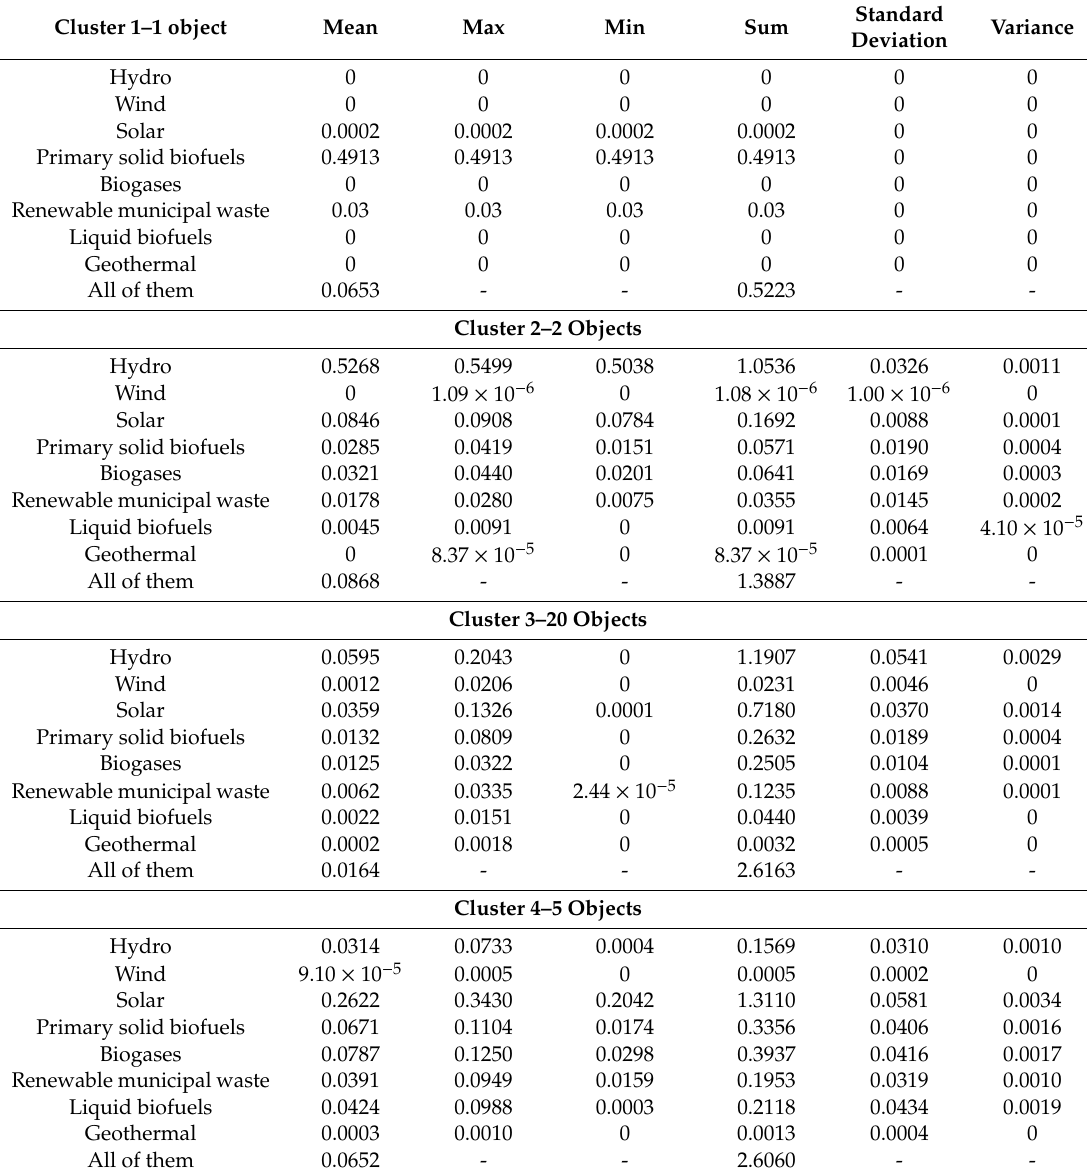
Table 24. Elements of clusters with distances from centers (own